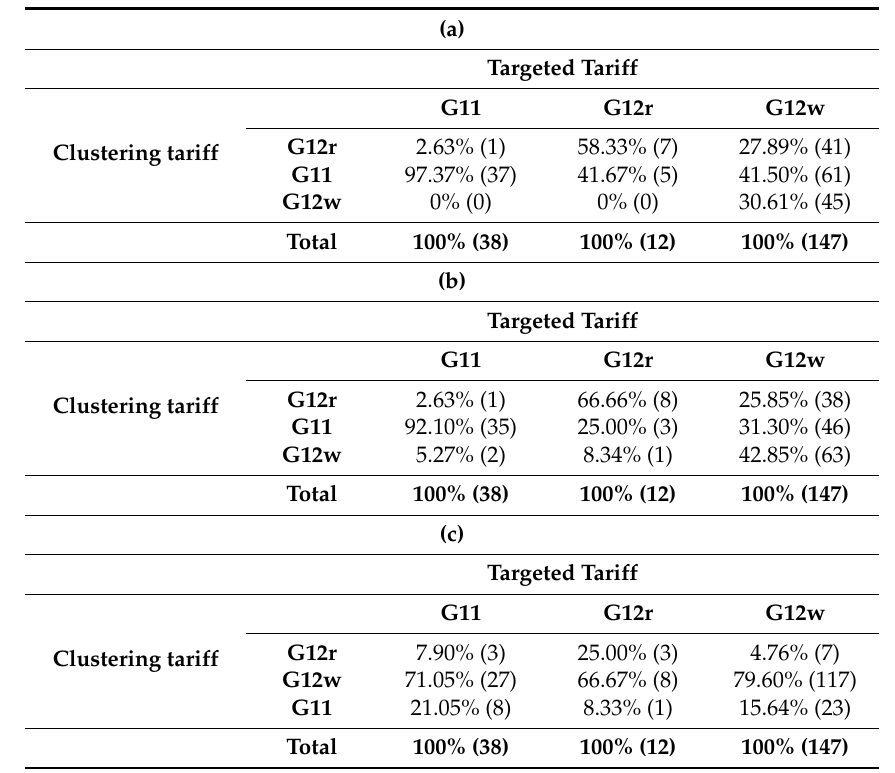
Table 3. Classification matrices for: (a) hierarchical clustering, (b) k-means clustering, and (c) supervised clustering.